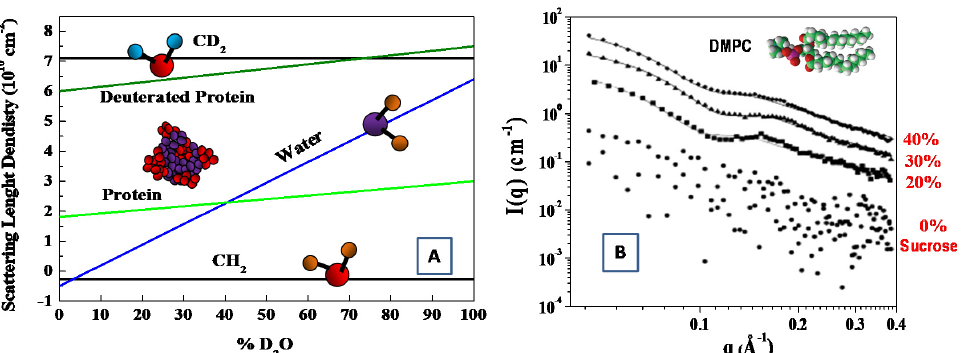
Figure 3. Scattering length density versus percentage of D 2 O in solution for protein and CH 2 molecules ( A ) (adapted from Jacrot [38]). SAXS curves at T = 30 °C for extruded dimyristoylphosphatidylcholine (DMPC) vesicles in the aqueous solutions with sucrose concentrations of 0% (circles), 20% (squares), 30% (triangles) and 45% (rhombuses) ( B ). (adapted from Kiselev et al. [45]).